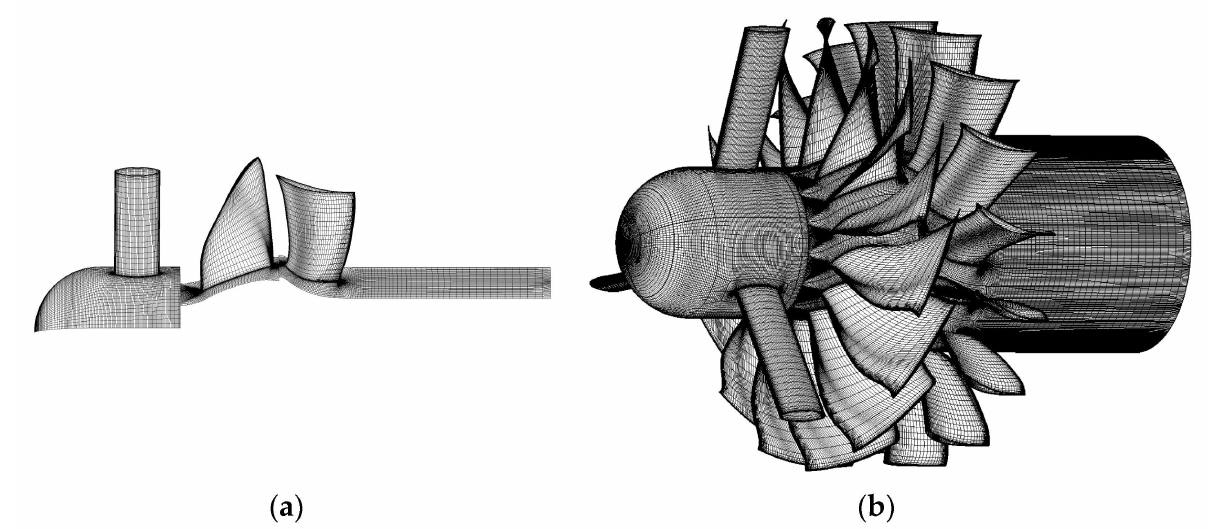
Figure 6. Grid topology of 3D CFD simulation: ( a ) single passage, ( b ) full